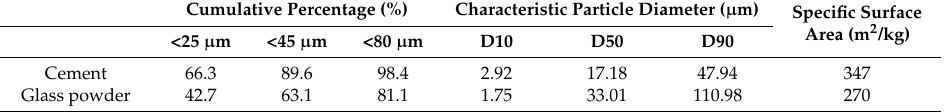
Table 3. Particle size distribution and specific surface area of cement and glass powder.